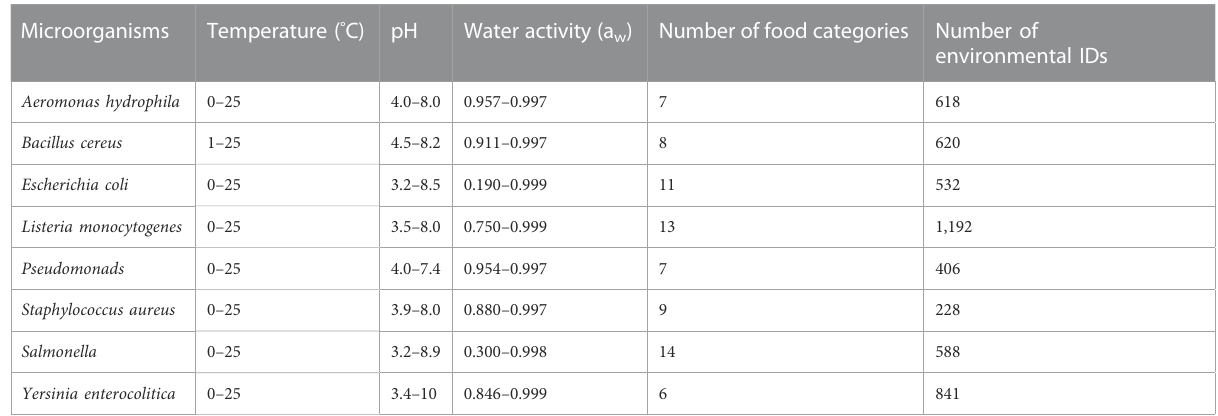
TABLE 1 Summary of the extracted data from